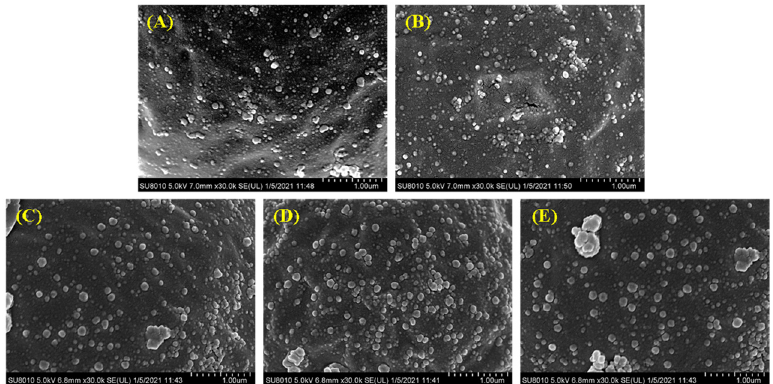
Figure 5. Cryo-scanning electron microscopy (SEM) images of the freshly prepared filled hydrogels containing different CaCl 2 levels. ( A – E ) correspond to images of filled hydrogels sample containing CaCl 2 levels of 0, 2, 4, 6, and 8 mM.